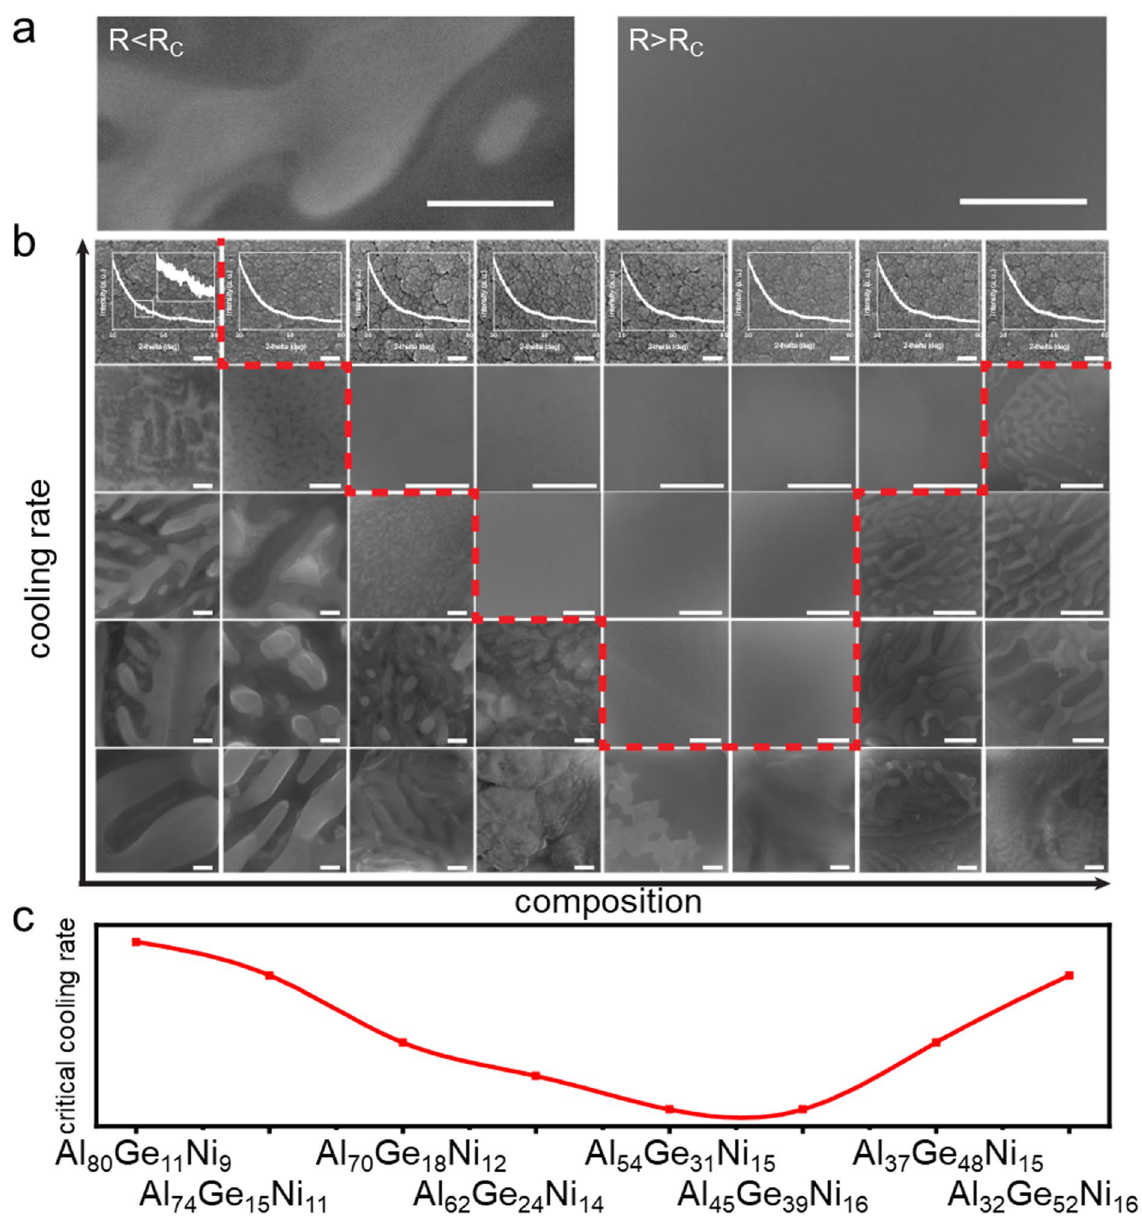
Figure 2. Microstructure analysis to reveal glass formation and critical cooling rate. ( a ) Characteristic microstructure for a crystalline alloy, R < R c and an alloy that vitrified and formed glass, R > R c (scale bar: 100 nm). ( b ) Microstructure mapping of Al 80 Ge 11 Ni 9 , Al 74 Ge 15 Ni 11 , Al 70 Ge 18 Ni 12 , Al 62 Ge 24 Ni 14 , Al 54 Ge 31 Ni 15 , Al 45 Ge 39 Ni 16 , Al 37 Ge 48 Ni 15 , and Al 32 Ge 52 Ni 16 (from left to right). This composition line is indicated in Fig. 3 as the white dashed line. Each column represents microstructures of one alloy for different cooling rates. The first row shows result of as-sputtered film, representing the highest cooling rate of ~ 10 8 K/s (with XRD curve superimposed). From the second row to the fifth row results from Single Pulse Laser Annealing of different 6 5 4 3 cooling rates, in sequence, 1 × 10 K/s, 2.5 × 10 K/s, 1.8 × 10 K/s, and 4.2 × 10 K/s are shown (scale bars: 100 nm). ( c ) Measured critical cooling rates which are based on the microstructure characterization of the eight compositions in ( b structure, we conclude that applied cooling rate is smaller than R c . If the alloy and cooling conditions reveal a homogenous amorphous microstructure, we conclude that applied cooling rate is larger than R c (Fig. 2a). This allows to determine R c as long as it is in the range of cooling rates of 10 2 –10 6 K/s which are achievable within this method. Example microstructures for different alloys (the dashed line from Al 80 Ge 11 Ni 9 to Al 32 Ge 52 Ni 16 in Fig. 3a) and various cooling rates are shown in Fig. 2b. Structural characterization through transmission elec- tron microscopy (TEM) have been attempted but abandoned due challenges originating from the low activation energy of nucleation and low melting temperatures in Al-based metallic glasses 39,40 .